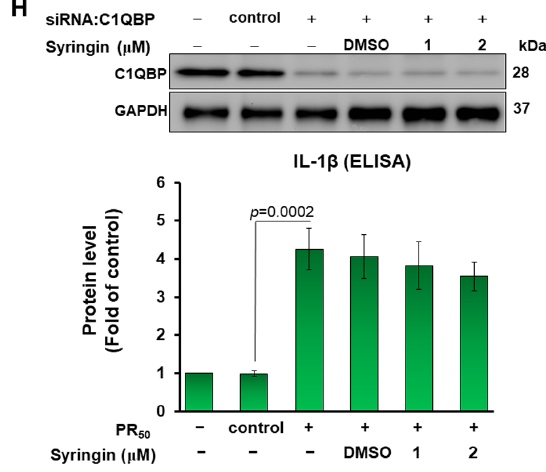
Figure 9. Syringin (SRG) inhibited NLRP3 inflammasome activity in PR 50 -expressing HMC3 mi- croglial cell. ( A ) HMC3 cells were treated with 0.25, 0.5, 1, 2, 4, or 8 µ M SRG for 24 h. Finally, the cell survival rate was determined by MTT assay. ( B ) Syringin (SRG) inhibited the interaction of PR 50 and C1QBP in co-immunoprecipitation (co-IP) assays. 293T cells were co-transfected with pCMV- PR 50 -myc and pCMV-C1QBP-HA. The cells were then lysed, 1 or 2 µ M SRG was added, and they were co-immunoprecipitated overnight with anti-myc antibody or anti-HA antibody, respectively. Finally, C1QBP and PR 50 were identified on co-IP complexes with anti-HA antibody or anti-myc antibody by Western blotting. ( C ) Immunofluorescence staining of NF- κ Bp65 (red) and Myc-tag (green). PR 50 -expressing HMC3 cells were treated with 1or 2 µ M SRG for 24 h. Treatment with SRG lessened the movement of NF- κ B p65 from the cytoplasm to the nucleus. DAPI was used for nuclear staining. ( D ) Extract of cell nucleus was analyzed for the level of NF- κ B p65 by Western blotting. TBP was used as a loading control. The bottom panel is a quantitative analysis graph using ImageJ software. ( E ) NF- κ B p65 transcription factor activity assay showed that treatment of SRG diminished NF- κ B activity. TBP was used as a loading control for input. ( F ) Cell lysates were analyzed for the expression of PR 50 (Myc) and NLRP3 inflammasome-related components by Western blotting. GAPDH was used as an internal loading control. The left panel is a representative set of images, and the right panel shows quantitative analysis graphs using ImageJ software. ( G ) The level of mature IL-1 β and mature IL-18 in the conditional medium were measured by ELISA. ( H ) Syringin (SRG) did not inhibit NLRP3 inflammasome activity in HMC3 microglial cells of C1QBP-knockdown. C1QBP siRNA-transfected HMC3 cells were treated with 1 or 2 µ M SRG for 24 h. The level of C1QBP was analyzed by Western blotting. GAPDH was used as an internal loading control (Top panel). The level of mature IL-1 β in the conditional media were measured by ELISA (bottom